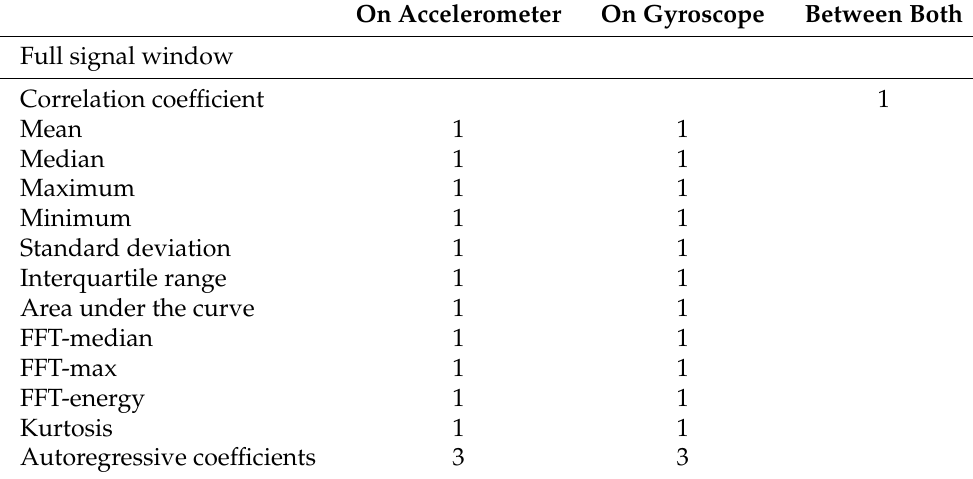
Table 1. Summary of the extracted features. The values indicate the number of features extracted for each signal